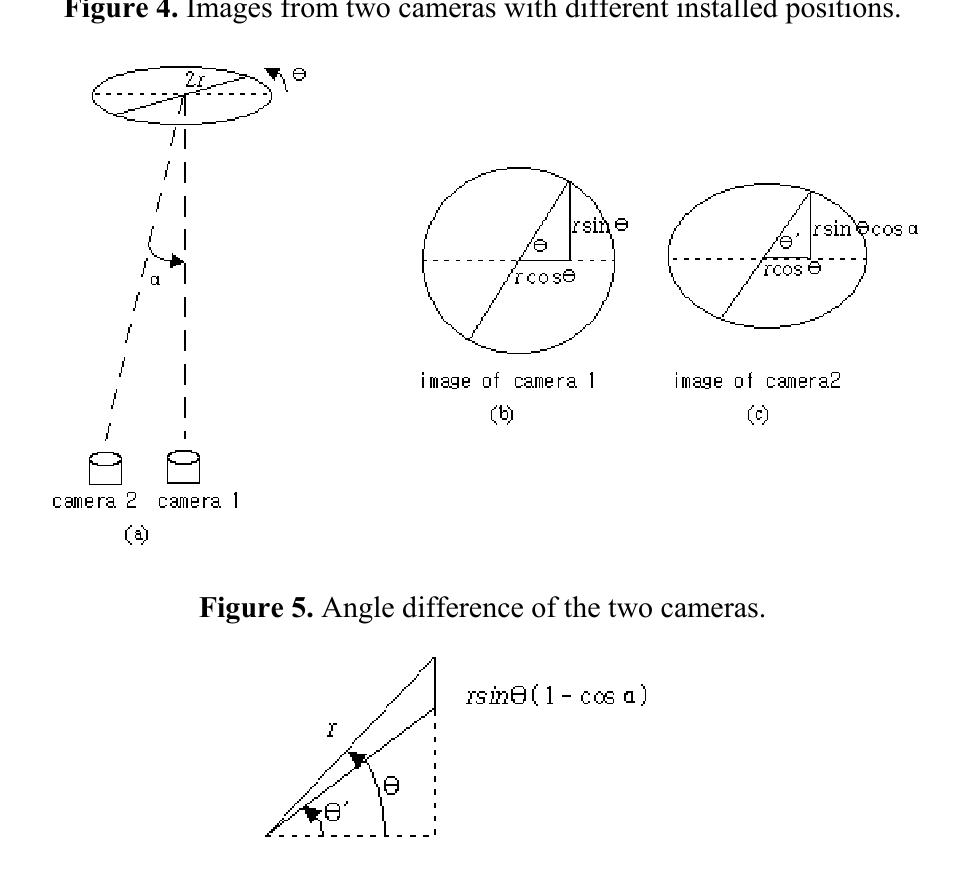
Figure 4. Images from two cameras with different installed positions.